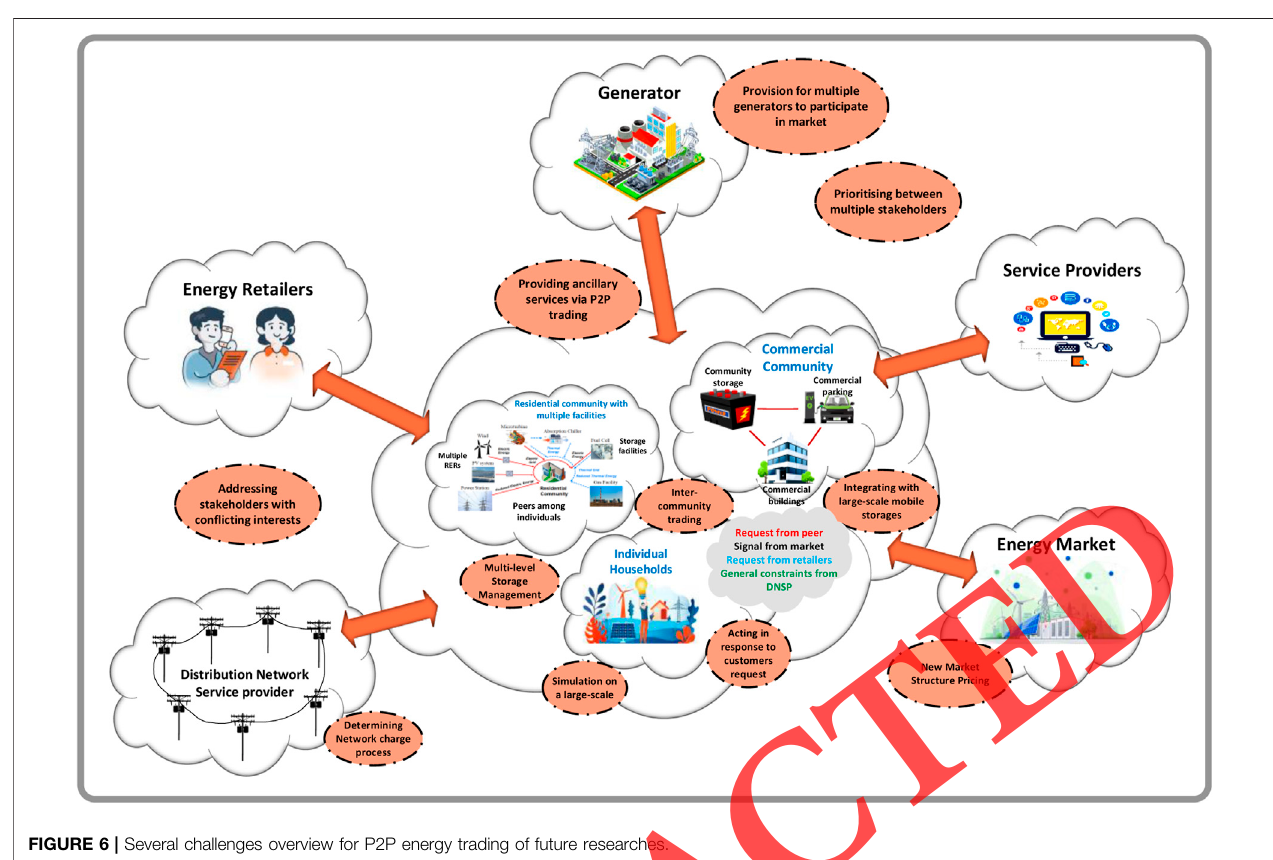
FIGURE 6 | Several challenges overview for P2P energy trading of future